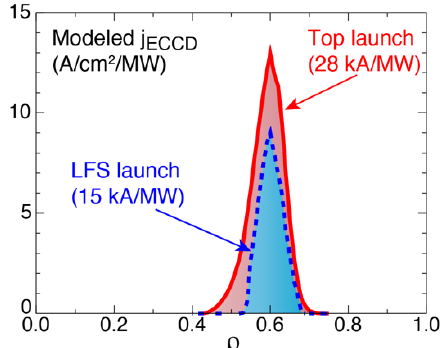
Figure 8:Driven current density profile for top launch and LFS launch for a DIII-D discharge modeled using CQL3D